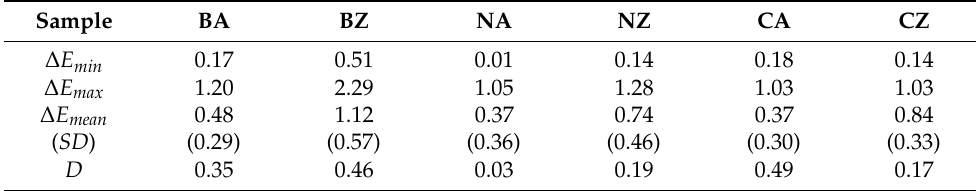
Figure 2. Total color differences for pairs of squares for each modified fabric. Parameters describing color differences on samples were calculated and shown in Table 7. Additionally, the standard deviation SD was calculated. Table 7. Parameters describing color differences on